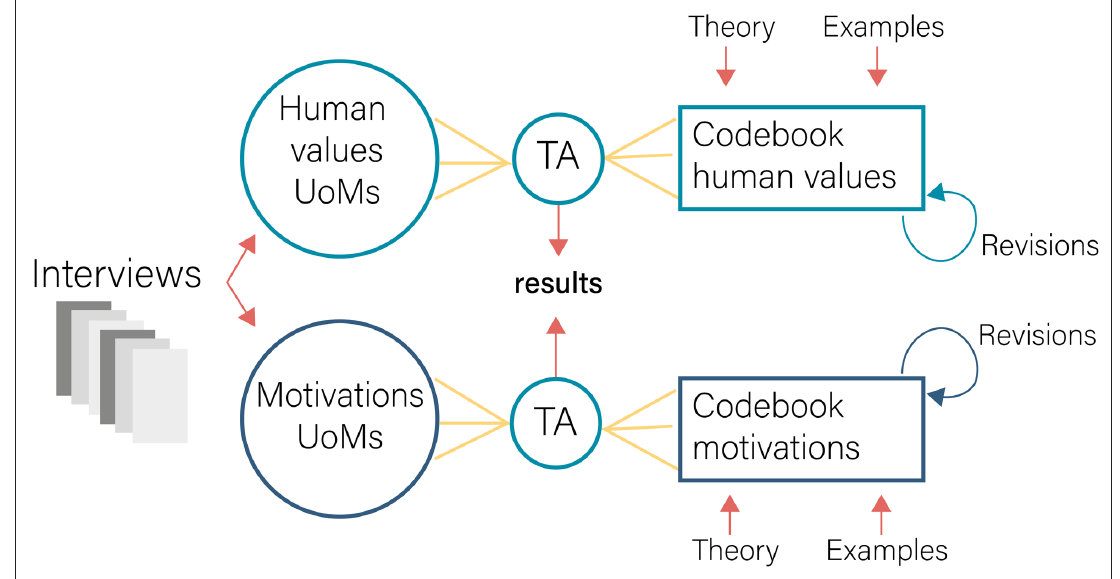
Figure 4: Data analysis overview (UoMs: units of meaning; TA: thematic analysis).